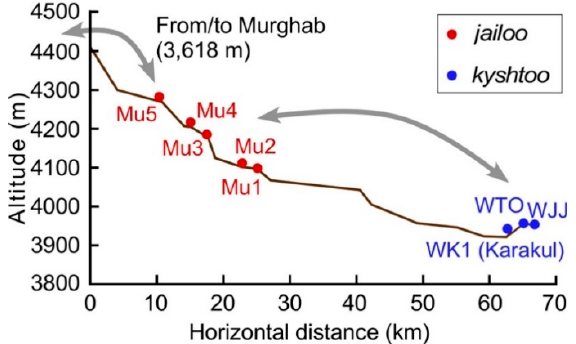
Figure 8. The longitudinal profile of the seasonal pastoral movement of the Muzkol group. Note that jailoo Mu5 is used by the outsiders from Murghab (3618 m).